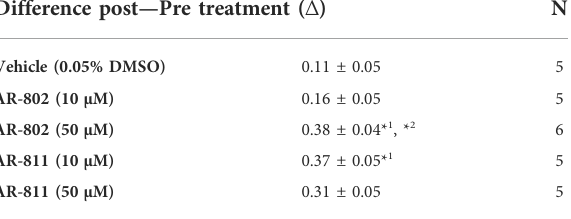
TABLE 9 E1784K FI onset from persistent I NA ( − 110